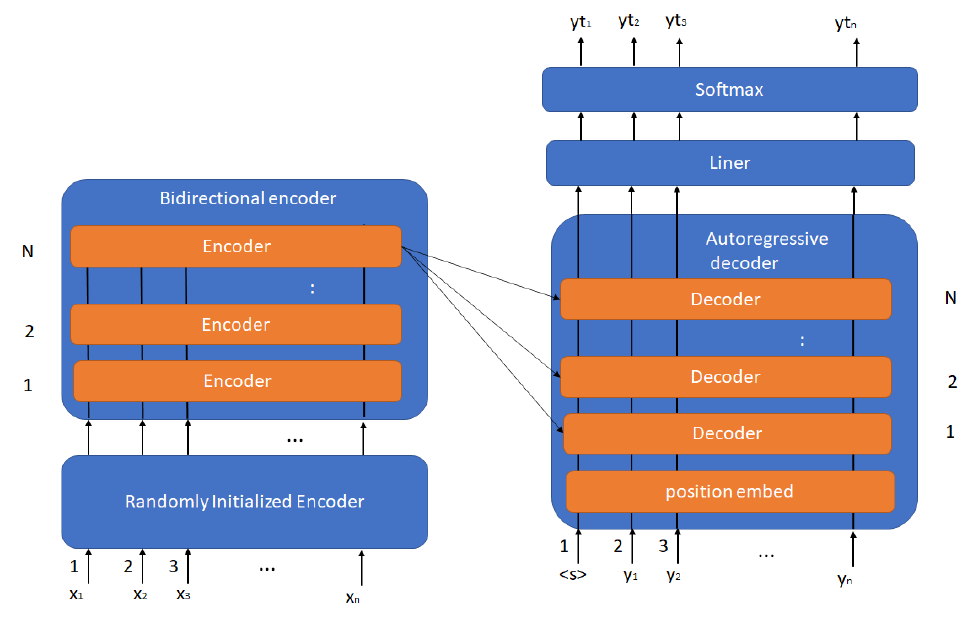
Figure 1. The BART model architecture.